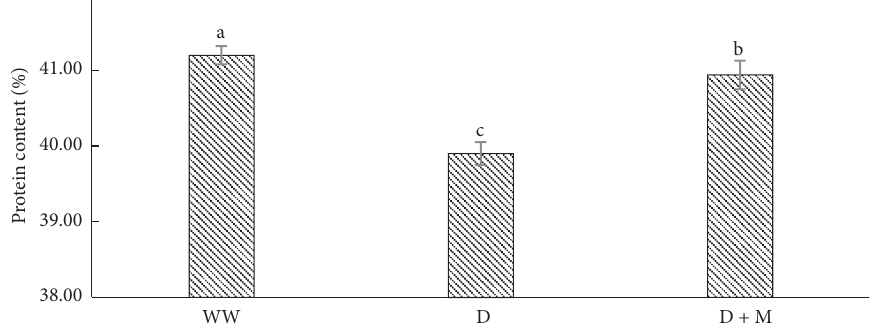
Figure 2: Effect of melatonin on protein contents in soybean under drought stress. Data are represented as average ± SD ( n � 3). Different letters indicate significant differences ( p < 0 .